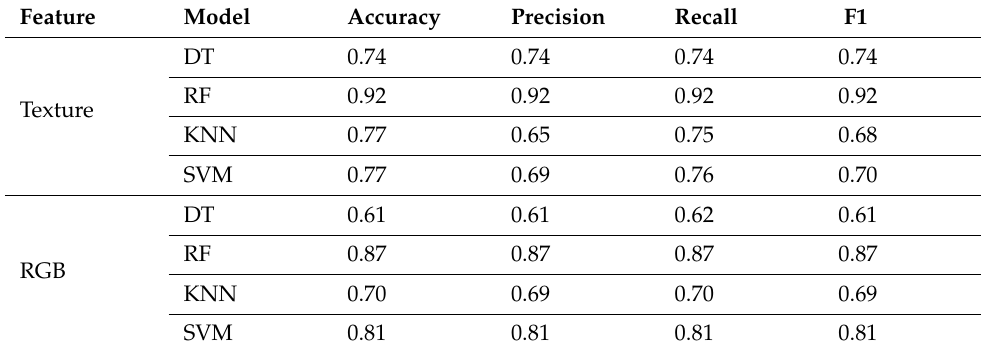
Table 10. Machine Learning Results on Over-sampled Dataset.